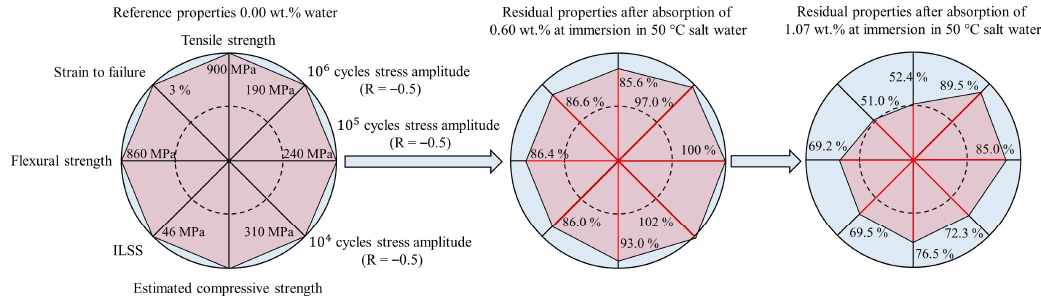
Figure 11. Cobweb diagram visualisation of the development of the mechanical properties as a function of the amount of absorbed water due to immersion in salt water at 50°C.